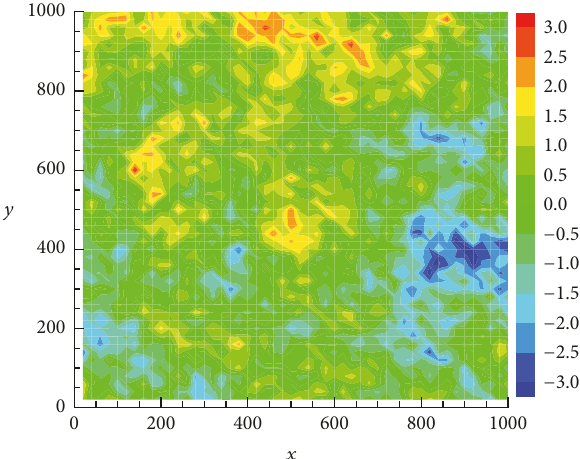
Figure 3: The generated unconditional multiscale random fractal field using KL expansion with the power variogram model parame- ters {𝐴 0 , 𝐻} = {0.046, 0.25} .